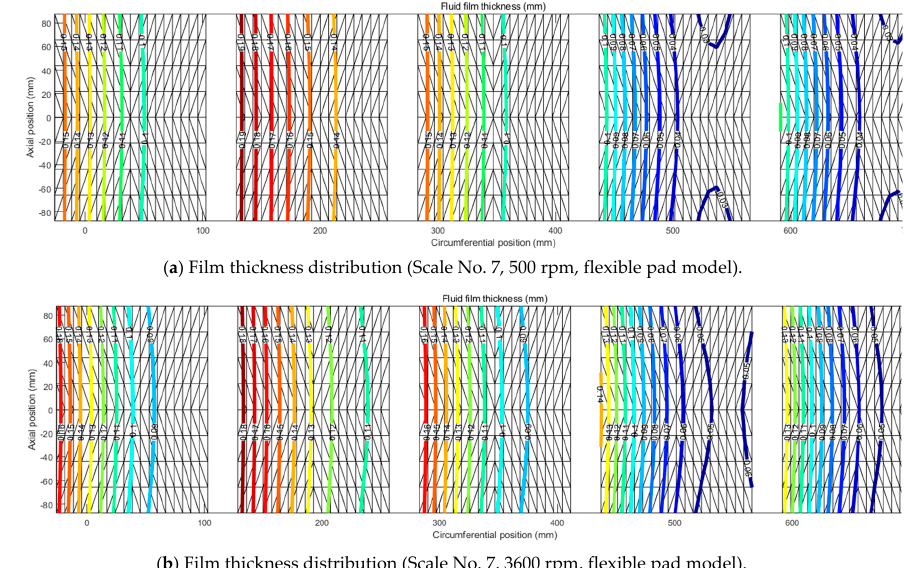
Figure 8. Thermal gradient of tilting pad journal bearing system.